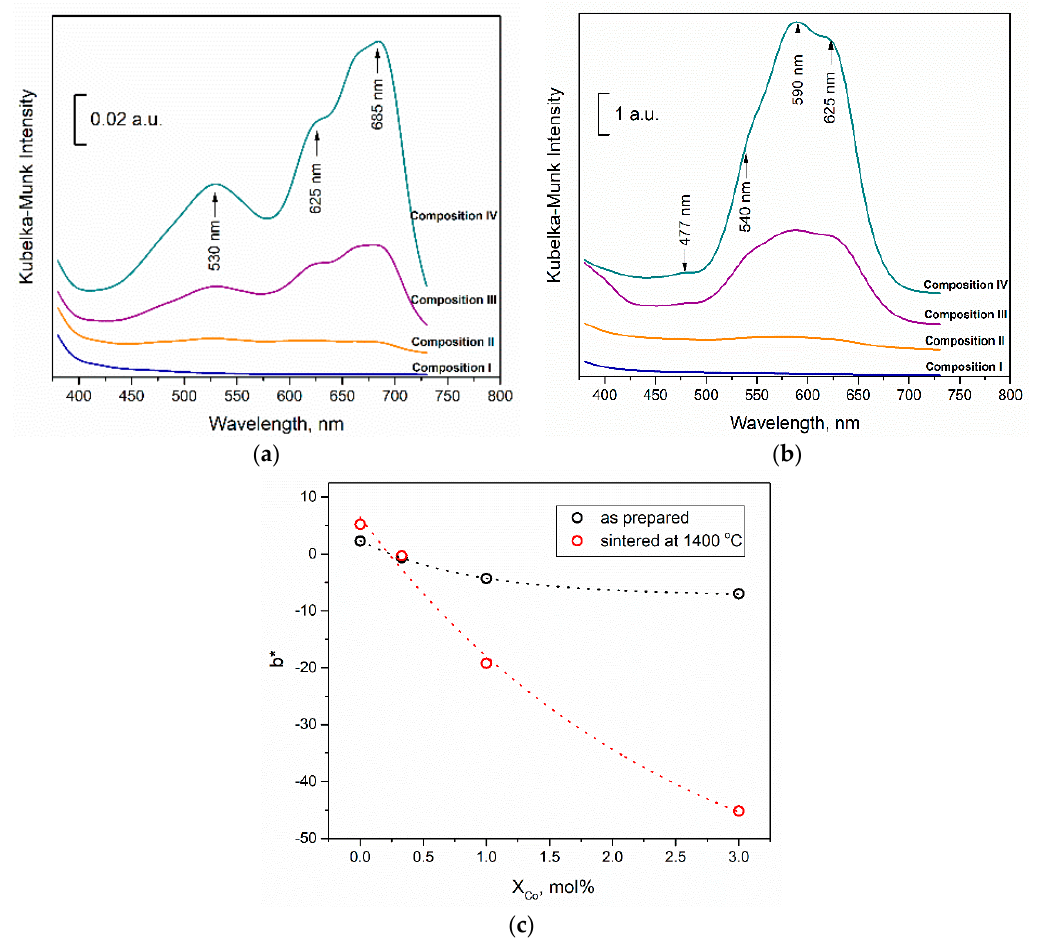
Figure 6. UV–vis absorption spectra of the powders ( a ) and sintered at 1400 °C ceramics ( b ) dependent the composition, plot of blue color intensity provided by b* CIE L*a*b* parameter in agreement with cobalt concentration ( c ).